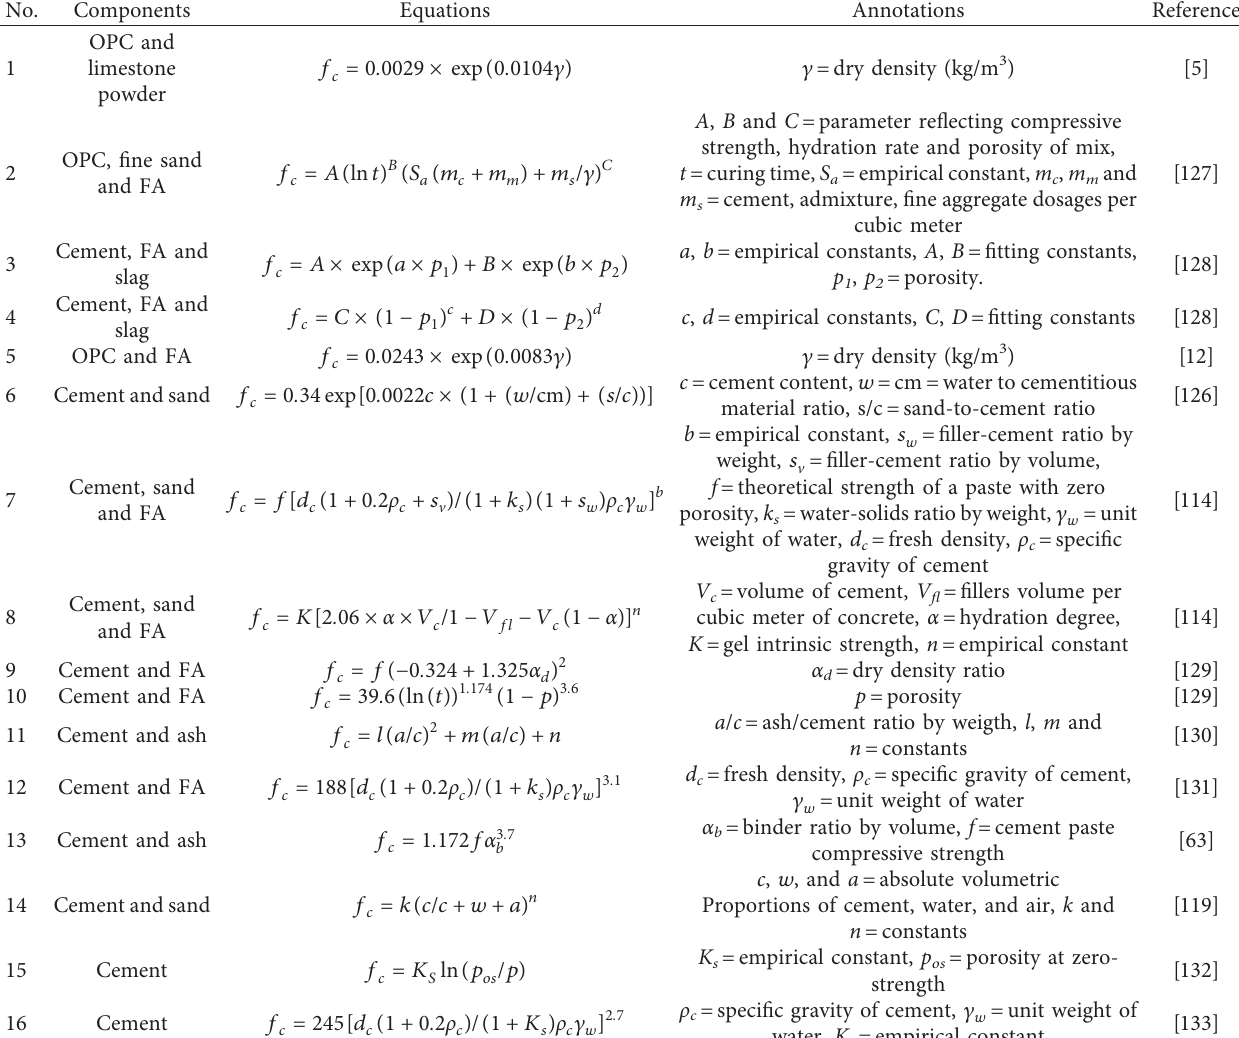
Table 4: Prediction models for compressive strength of